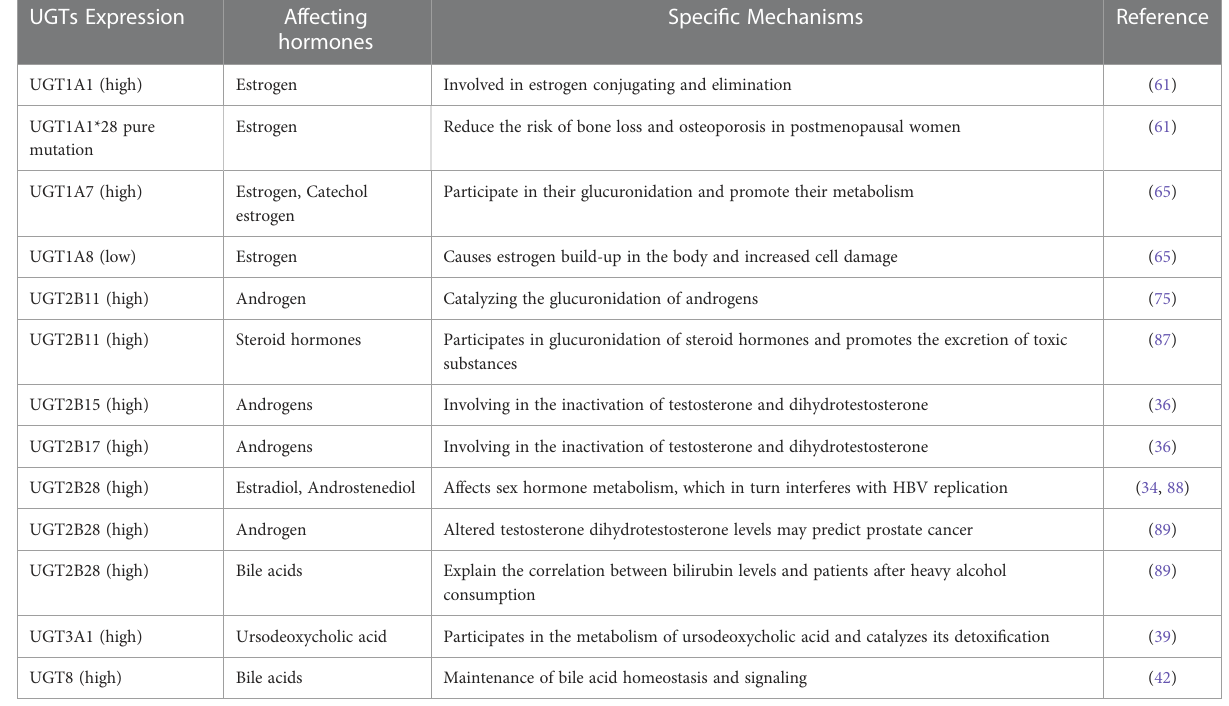
TABLE 3 Relationship between expression of UGTs and hormone metabolism. UGTs